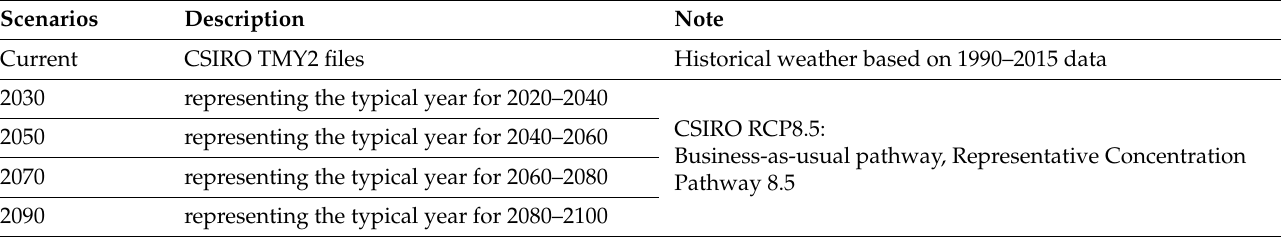
Table 8. Description of CSIRO weather files used in this